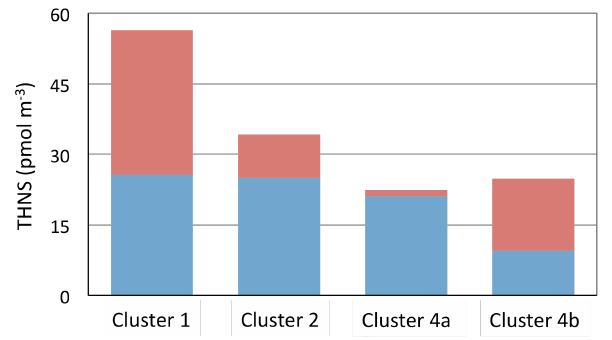
Fig. 5. Median THNS mass concentrations (pmolm − 3 ) of parti- cles in the sub-micrometer (blue) and super-micrometer (red) size Figure 5. Median THNS mass concentrations (pmol m -3 ) of particles in the submicron (blue) and 3 ranges, calculated for in trajectory cluster 1, 2, 4a and 4b, respec- tively. supermicron (red) size ranges, calculated for in trajectory cluster 1, 2, 4a and 4b, respectively. 4